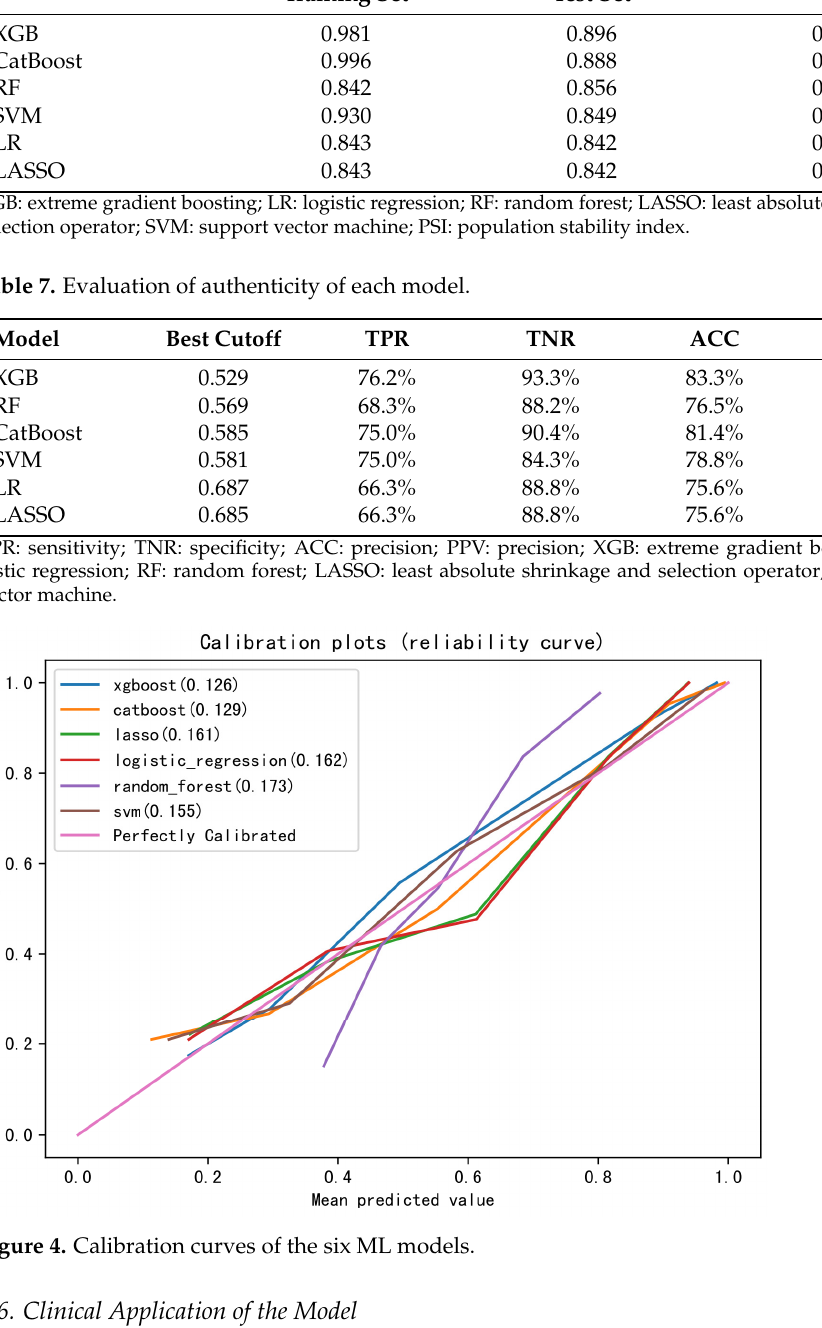
Figure 5. Decision curve analysis of the six ML models.